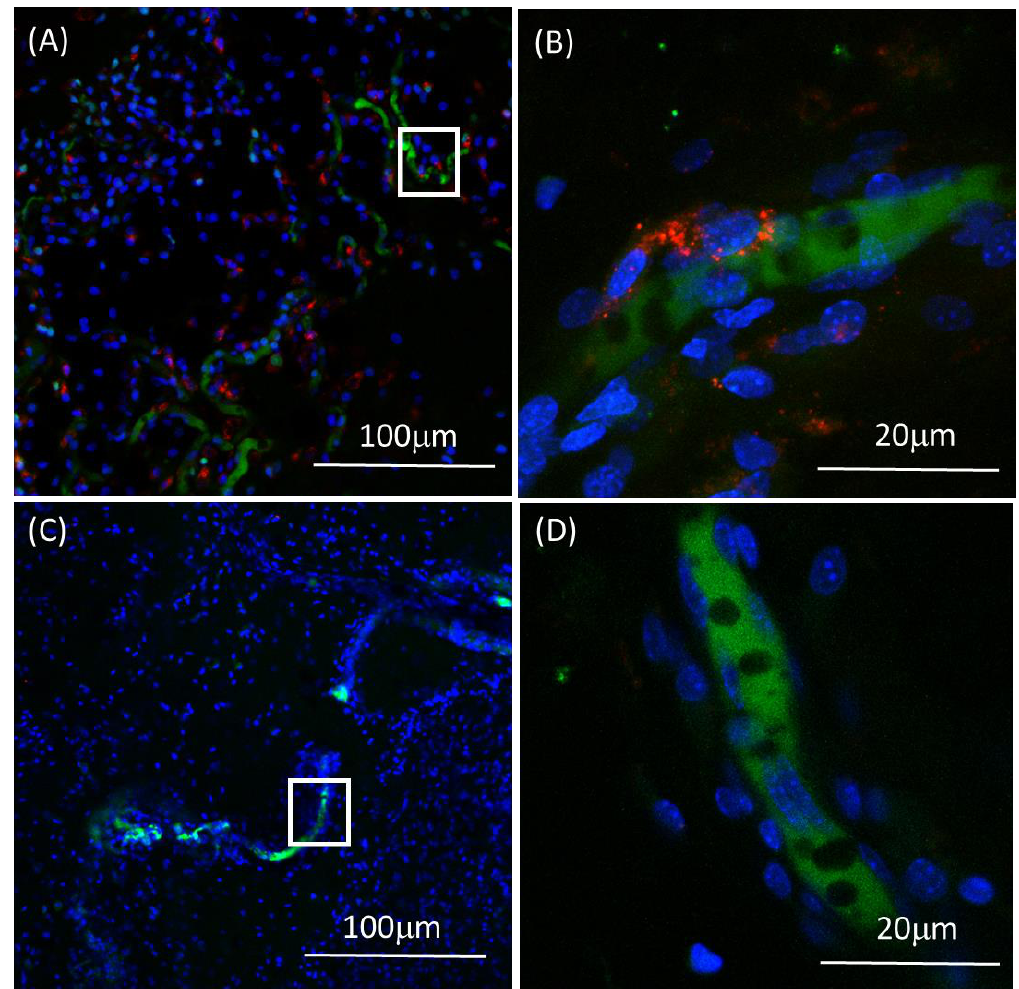
Figure 7. Tracking transplanted EPCs 10 days after transplantation in a mice model. ( A ) Test sample, EPCs (red) were detected in the new tissue. ( B ) Higher magnification of A showing EPCs (red) lining blood vessel lumen (green). ( C ) Control sample, blood vessels stained in green and the endogenous cells stained blue. ( D ) Higher magnification of C. cells stained blue. ( D ) Higher magnification of